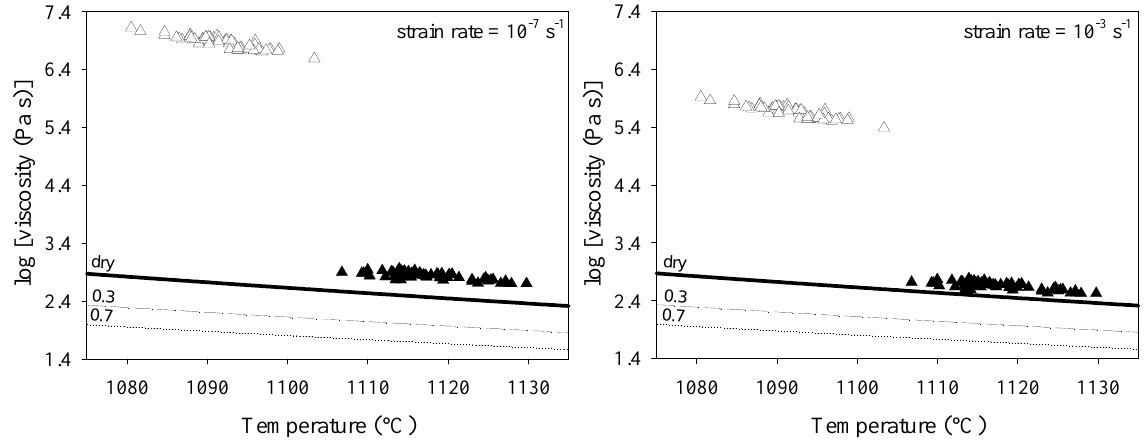
Fig. 5. Calculated liquid-crystal viscosity as a function of temperature for the magmas erupted during the Strombolian (open symbols) and fire-fountain (solid symbols) phases of the 2000 Mt. Etna activity. The calculations assume a crystal volume fraction of 0.37 for the fire-fountain phase and 0.57 for the Strombolian phase (see text and Table 1). The viscosity of pure liquids at anhydrous and dissolved water contents (reported in the figure) of 0.3 and 0.7wt%, calculated with the GRD model, are also shown as lines in the figure. At the same temperature (in the interval between 1050 and 1150 ◦ C) and H 2 O content (dry to 0.7wt%) the average viscosity difference calculated for liquids of composition of the glass matrices of Strombolian and fire-fountain products is about 0.2 logunits. This difference reduces at 0.15 and 0.08 logunits at water content of 2.0 and 4.0 as those adopted in the simulations. This effect would not affect the overall results of the numerical simulations.